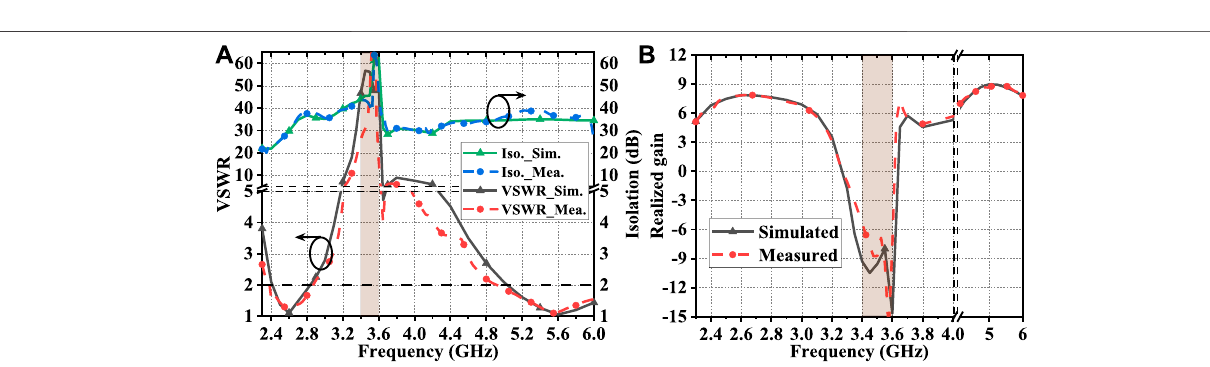
FIGURE 13 | Fabrication of the proposed band-notched antenna. (A) Photograph view. (B) Top view.